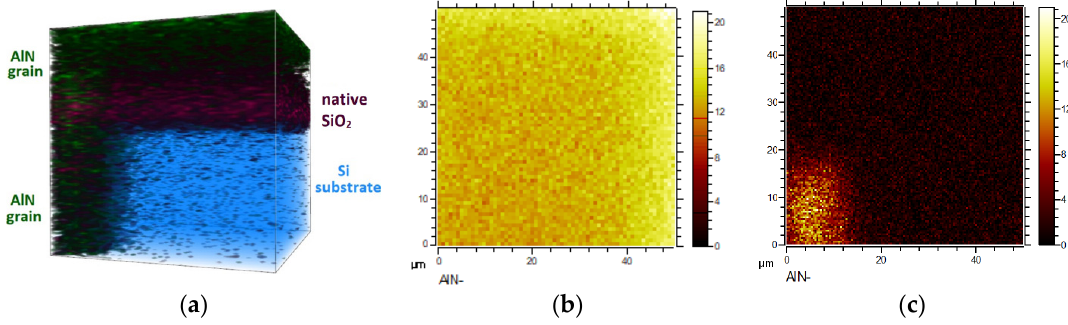
Figure 12. ( a ) 2D distribution of AlN − ions for samples without temperature treatment; ( b ) 2D distribution of AlN − ions for samples with temperature treatment; ( c ) 3D distribution of AlN − , SiO − , and Si − ions of a sample with temperature treatment.